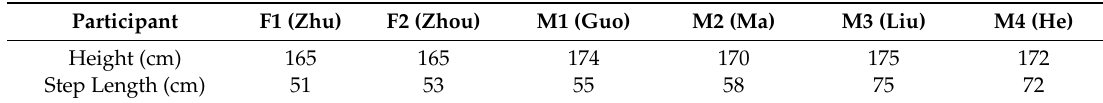
Table 3. The height and step length of six